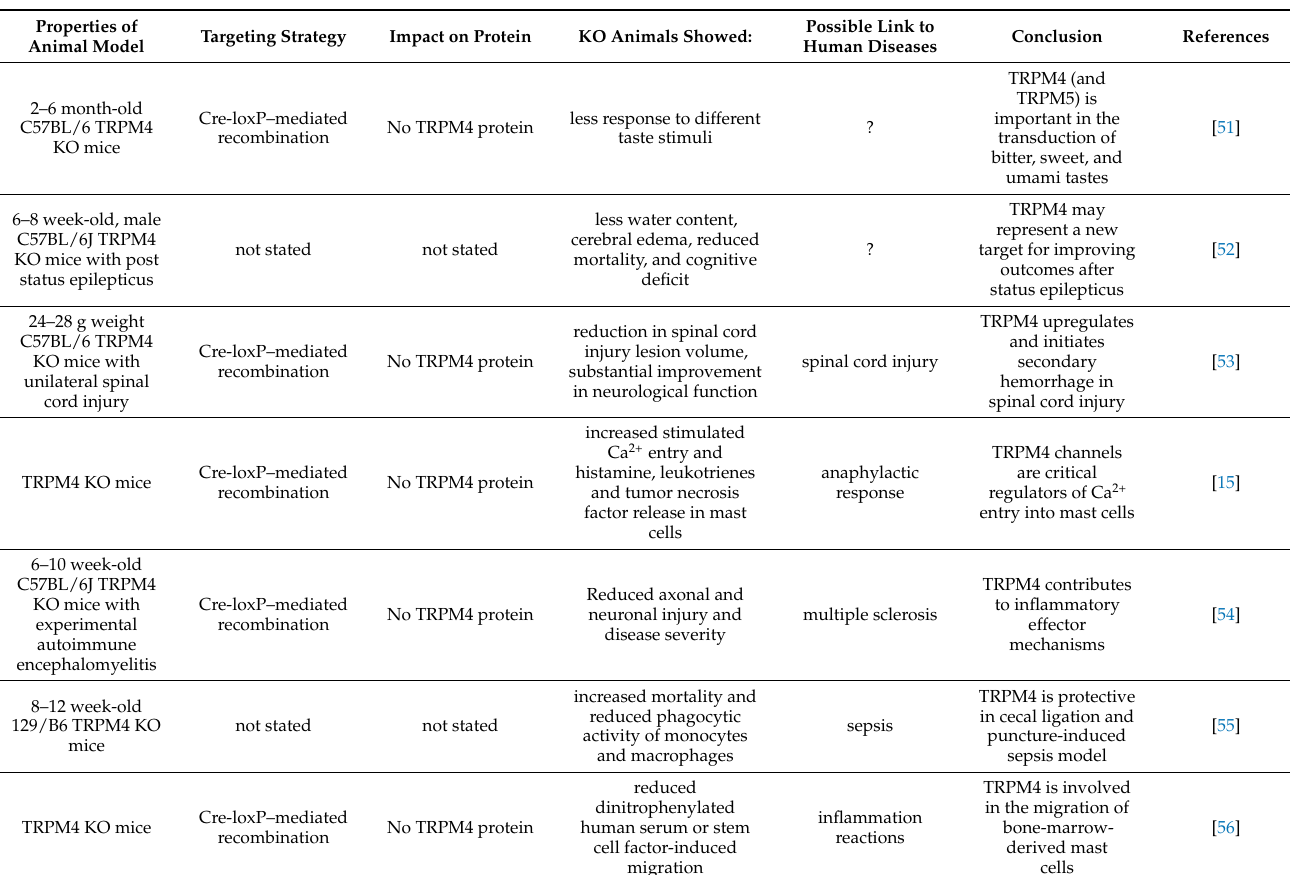
Table 1. Summary of murine non-cardiac TRPM4 KO animal